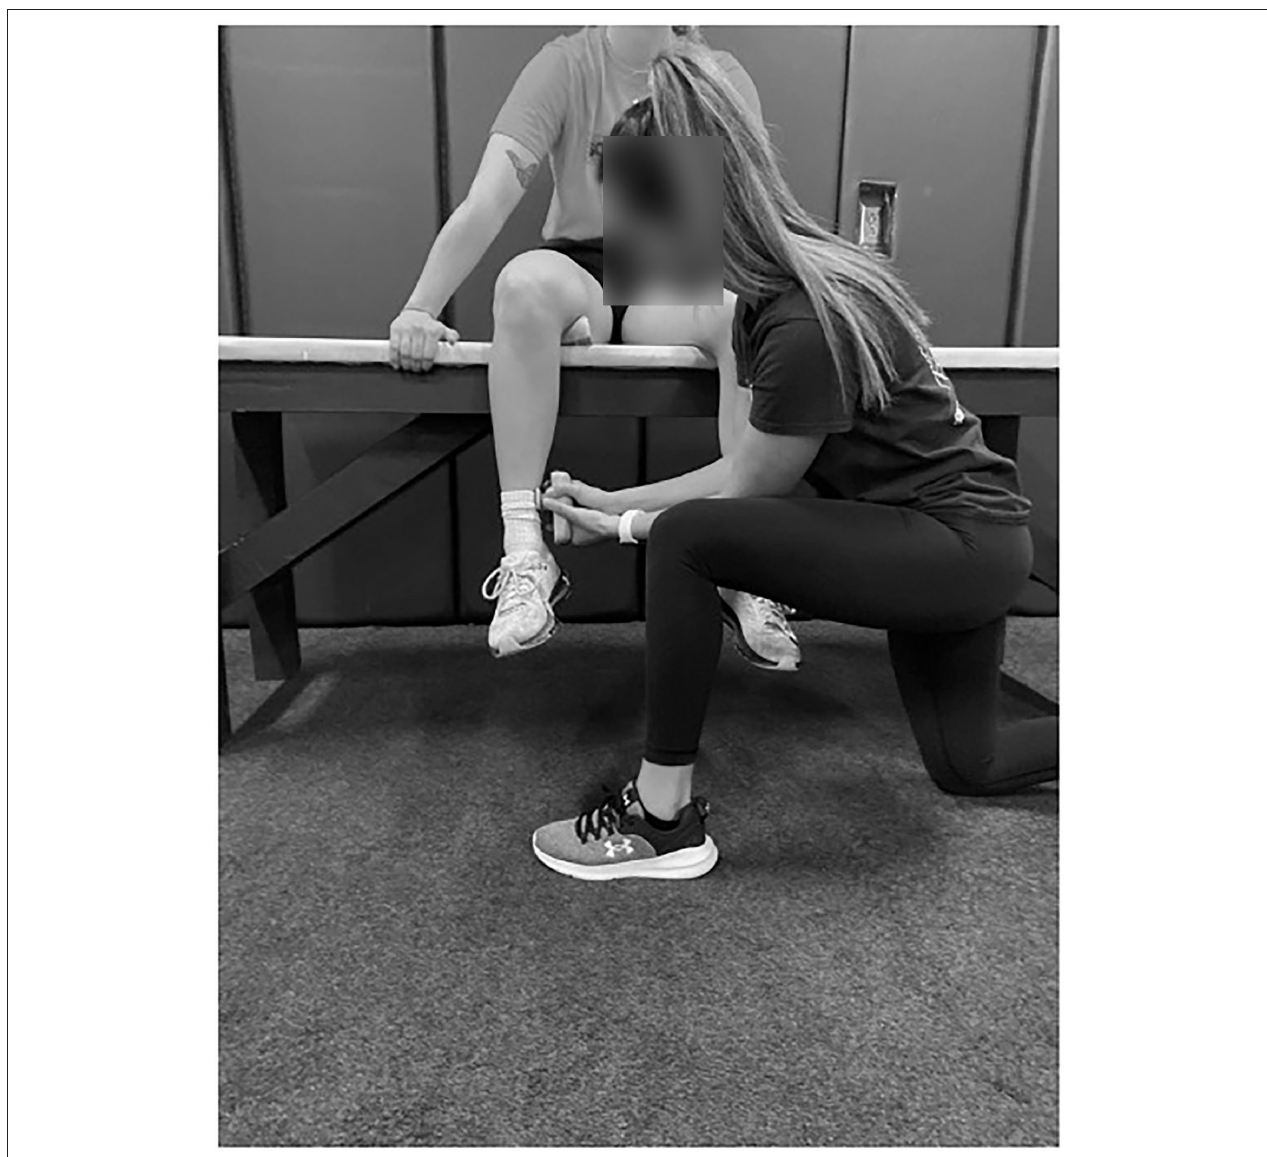
FIGURE 3 | Hip ER ISO